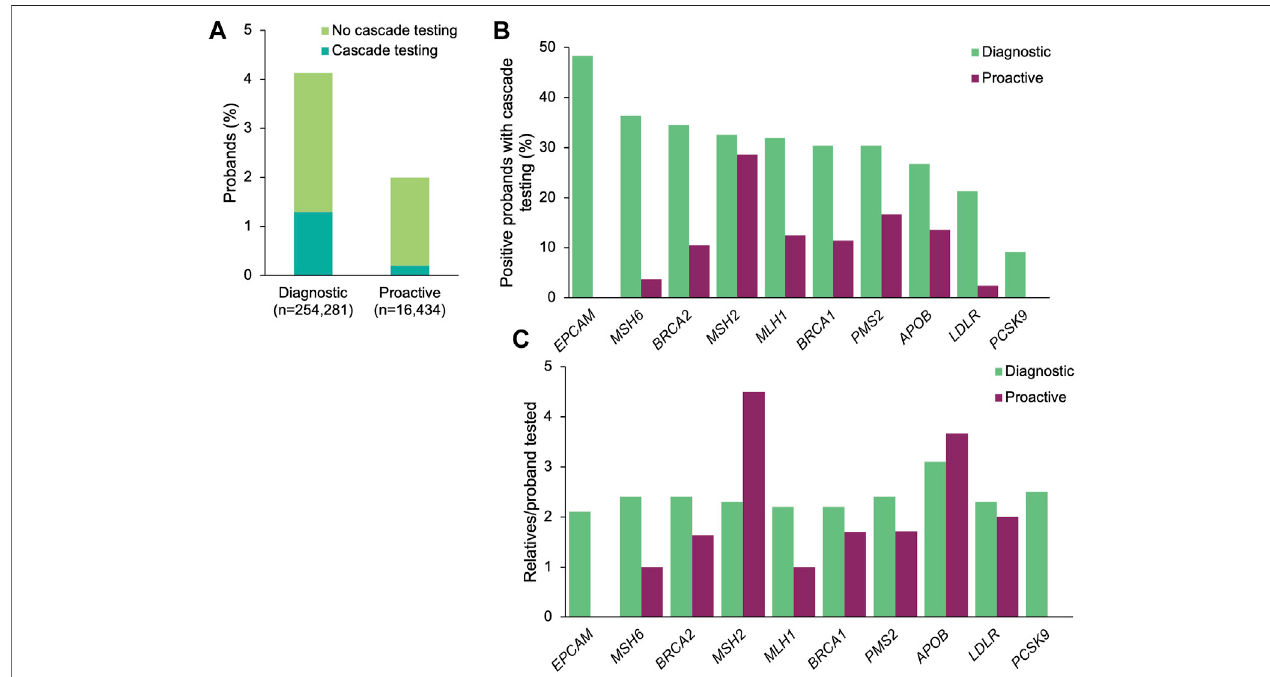
FIGURE 1 | Yield of medically actionable fi ndings in probands among the 11 genes associated with a CDC Tier 1 condition and rates of cascade testing. (A) Proportion of diagnostic and proactive probands with a positive result in a gene associated with a CDC Tier 1 condition, strati fi ed by whether cascade testing was pursued. The denominator was the total number of probands that underwent diagnostic testing ( n = 254,281) or proactive screening ( n = 16,434). (B) Proportion of probands with a medically actionable result in a gene associated with a CDC Tier 1 condition with at least one relative who pursued cascade testing. The denominator was the number of probands with a medically actionable result in each gene associated with a CDC Tier 1 condition for each cohort. Probands with a positive fi nding in more than one gene associated with a CDC Tier 1 condition were included in calculations for each gene. (C) Mean number of relatives who pursued cascadetestingperprobandwithapositiveresultinageneassociatedwithaCDCTier1condition.Ifcascadetestingwaspursuedforpositive fi ndingsinmorethanone gene detected in the proband, the relatives and probands were included in the calculations for each gene. CDC, Centers for Disease Control and